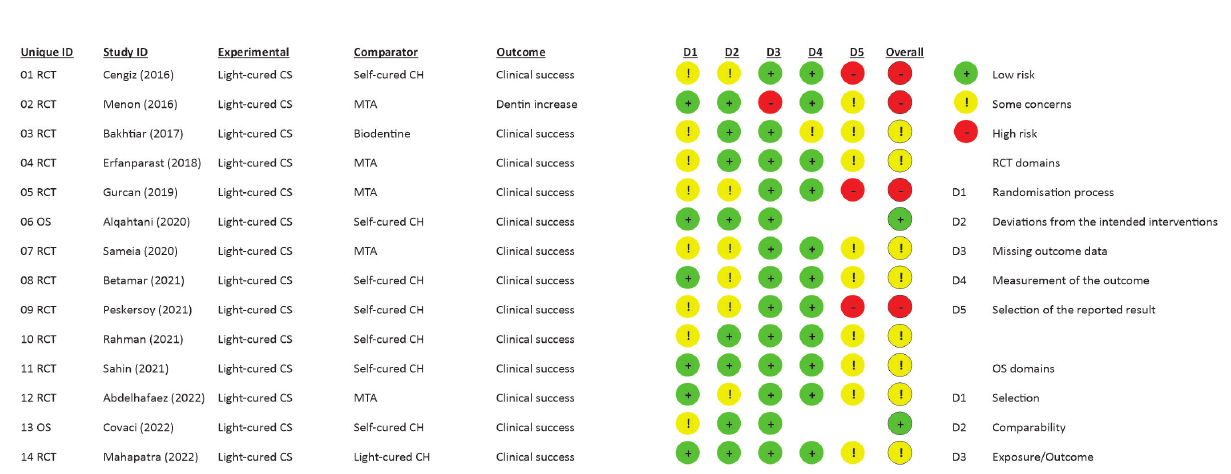
Figure 2. Risk of bias of the studies included in the systematic review. Table 5. Quality assessment of the included studies in the systematic